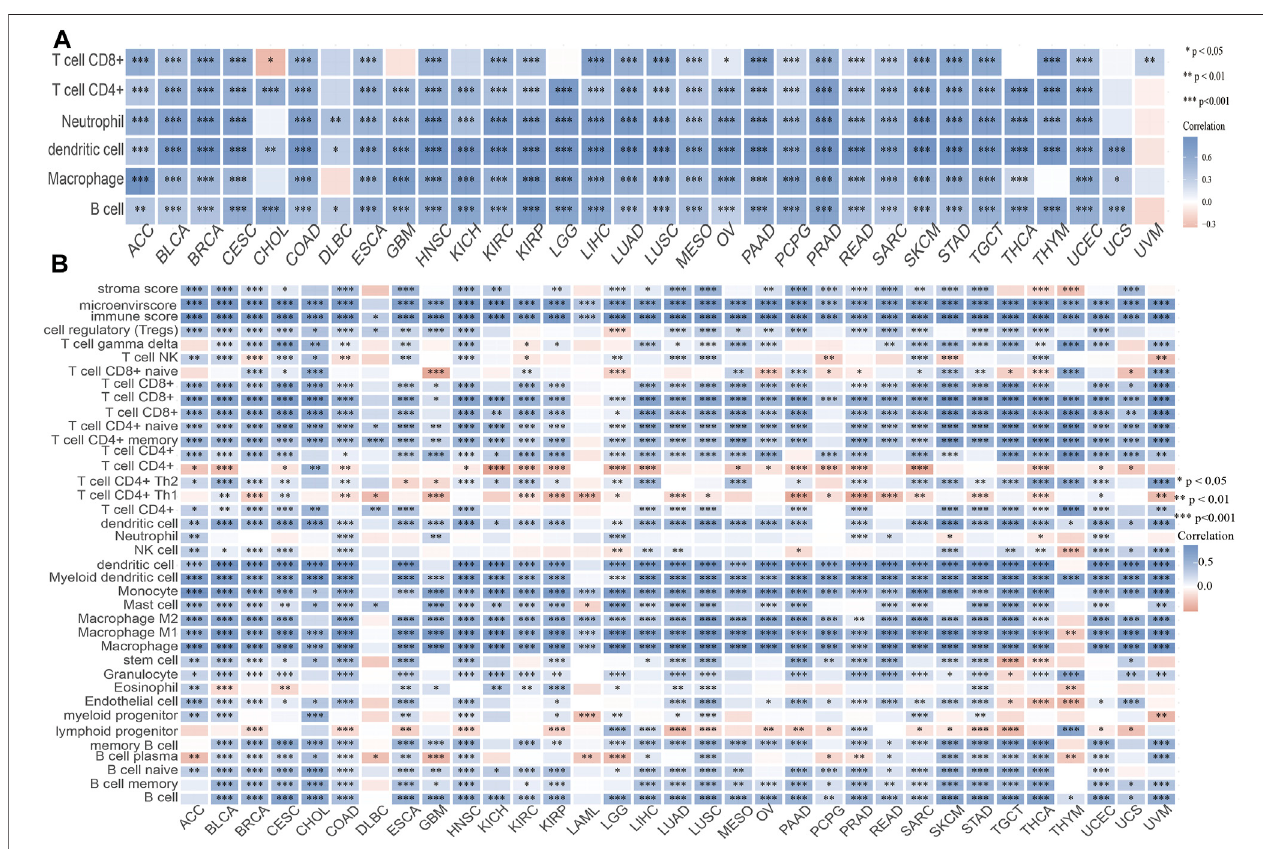
FIGURE6| AnalysisofthecorrelationbetweentheUBE2Cexpressionandimmunecellin fi ltration. (A) ThecorrelationbetweenUBE2Cexpressionandimmunecell in fi ltrationinpan-cancerexaminedbytheTIMERdatabase. (B) ThecorrelationbetweenUBE2Cexpressionanddiverseimmunecellsin fi ltrationinpan-cancerexamined by X-Cell database. * p < 0.05, ** p < 0.01, *** p < 0.001.